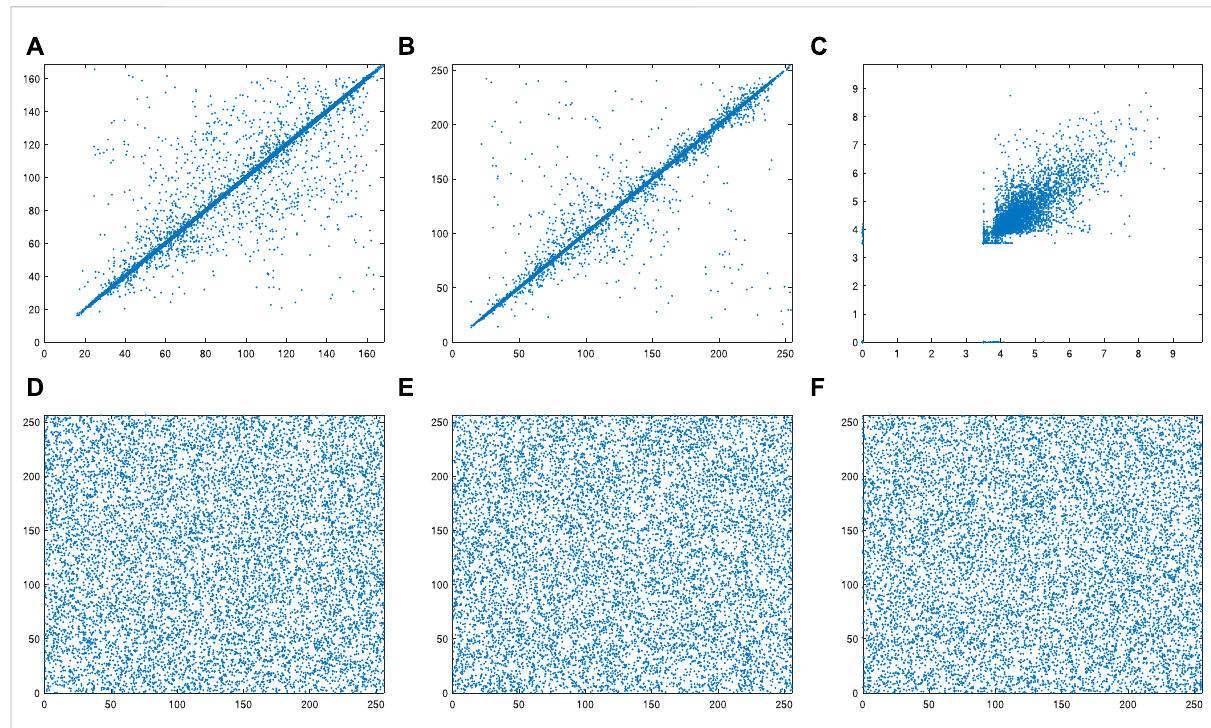
FIGURE 13 Correlation analysisofTopographic mapofSouth Korea. (A) X-directionofplaintext. (B) Y-directionofplaintext. (C) Z-direction ofplaintext.